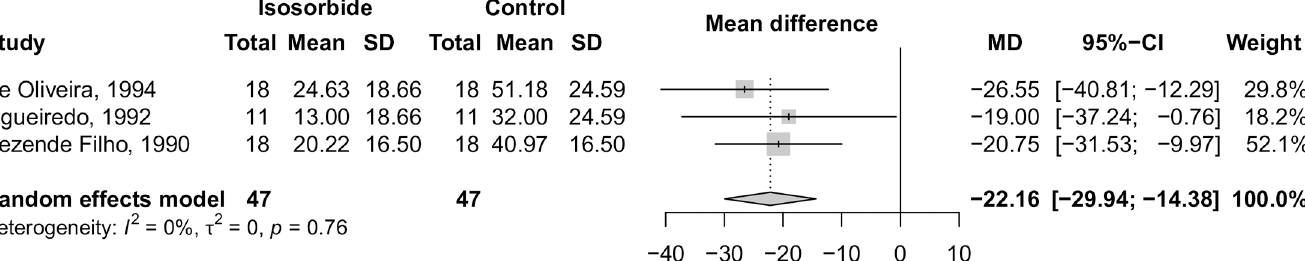
Fig 3. Effect of isosorbide on esophageal retention 5 minutes after meal ingestion. Esophageal retention is an indicator of esophageal emptying.